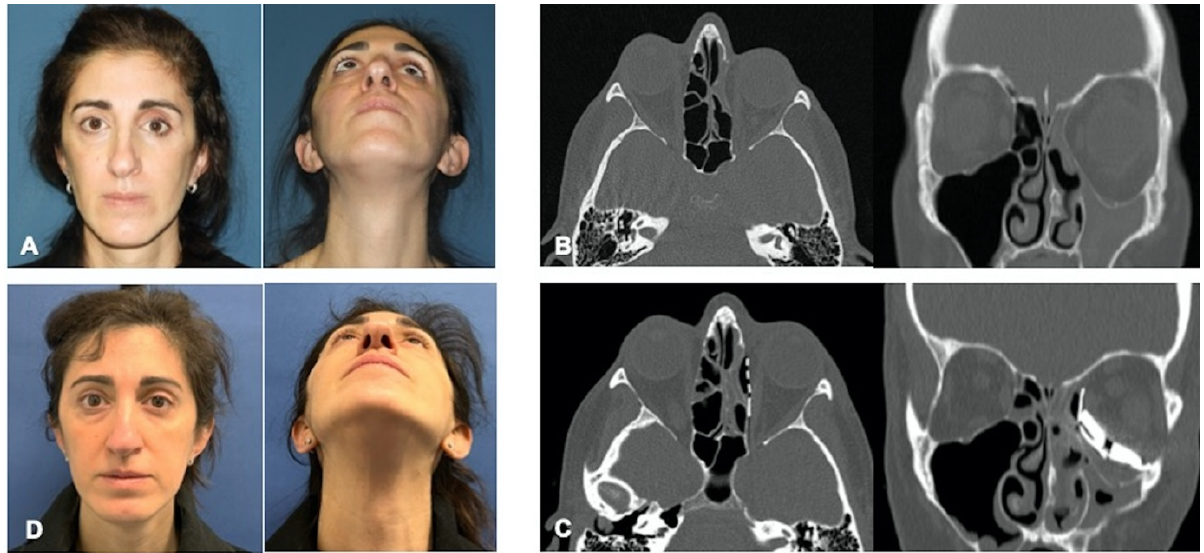
Figure 1. ( A ): Preoperative pictures at the time of patient presentation and diagnosis of left SSS, showing hypoglobus and enophthalmos of the left eye. ( B ): Pre-operative CT scan. Axial and coronal views showing completely opacified and atelectatic maxillary left sinus and collapse of the left orbital floor and medial wall. ( C ): Post-operative CT scan. Axial and coronal views showing correct implant placement, stable spacers position, and successful FESS surgery. ( D ): Clinical follow-up 18 months after surgery, showing satisfactory correction of the visual deformity.